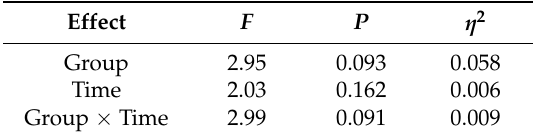
Table 3. Results of repeated measures ANOVA for SANS total score.